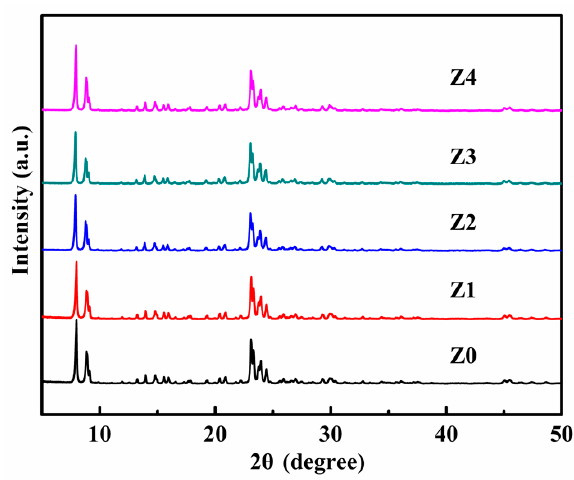
Figure 2. X-ray powder diffraction (XRD) spectra of the as-prepared catalysts.